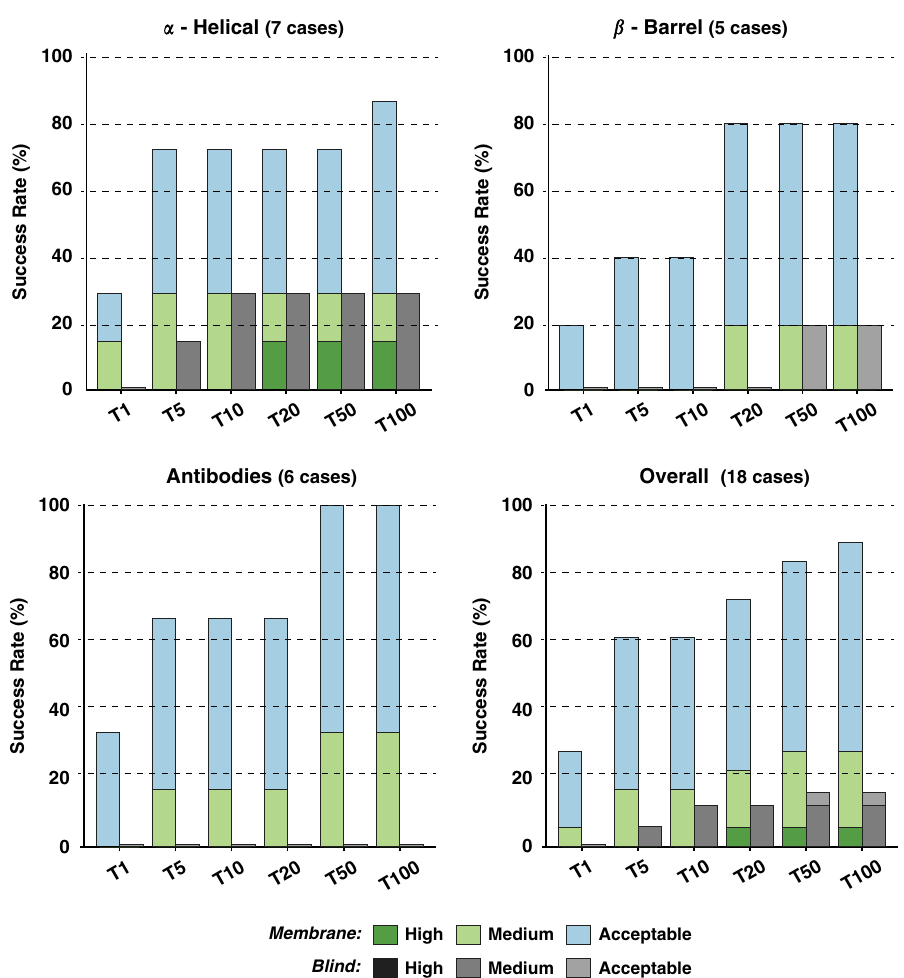
Fig. 3 Performance of the membrane protein integrative modeling protocol on the 18 cases of the membrane docking benchmark. Success rates are presented for each of the benchmark categories ( α - Helical , β -Barrel , and Antibodies ) as well as Overall (including all three different categories). Color coding from blue to green ( Membrane ) and grayscale ( Blind ) indicates the model quality (from acceptable to high) as de fi ned based on CAPRI criteria. Source data are provided as an excel fi optimization algorithm during the sampling and scoring